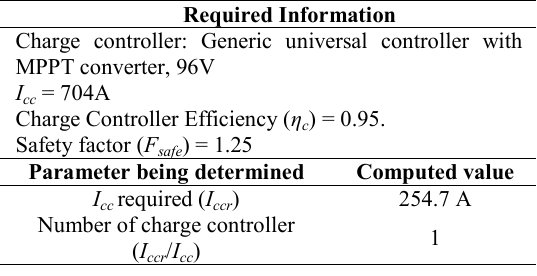
Table 7. Summary of charge controller sizing.